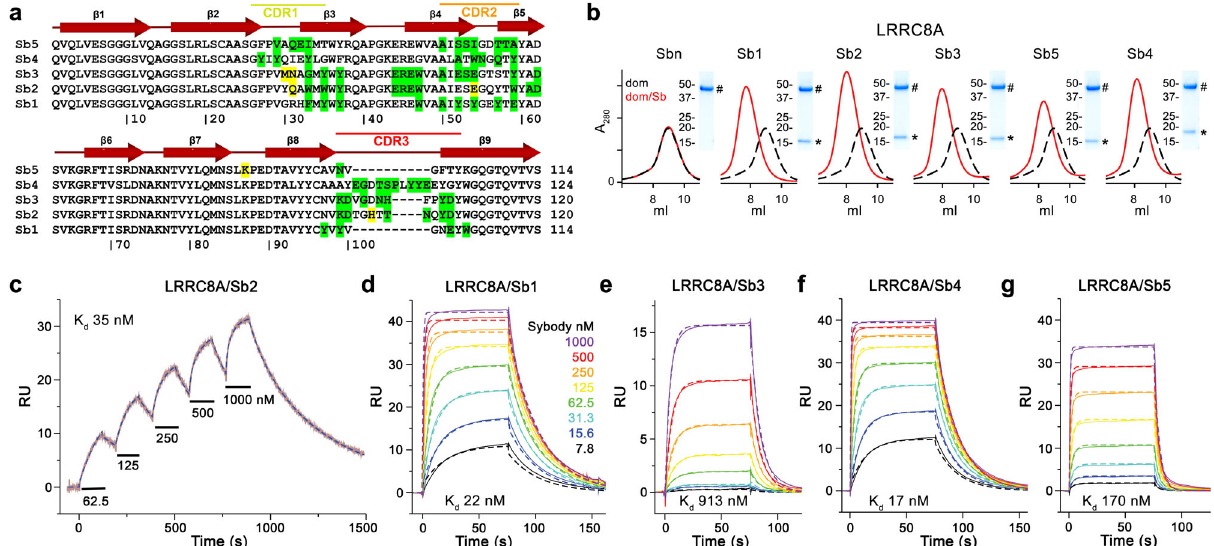
Fig. 1 Biochemical characterization of sybodies targeting the LRR domains. a Sequence alignment of the fi ve modulatory sybodies. Residues involved in the interaction with the primary subunit are highlighted in green, contacts to the secondary subunit in yellow. Secondary structure elements and location of CDRs are indicated above. b Sections of size-exclusion chromatograms showing the elution of the LRR domain of LRRC8A (black dashed line) and its complex with interacting sybodies (red). Sbn refers to the mixture of the LRRC8A domain with a sybody targeting a protein unrelated to the LRRC8 family. Insets show SDS-PAGE gels of the peak fractions with the LRR domain of LRRC8A (#) and co-eluted sybodies (*) indicated. Numbers refer to the molecular weight (kDa). c – g SPR experiments of sybodies binding to immobilized LRR domains of LRRC8A. c Characterization of the binding properties of sybody Sb2. Bars indicate application of the sybody at increasing concentrations (nM). d Af fi nity determination of sybodies Sb1, e Sb3, f Sb4, and g Sb5. d – g Individual traces show association and dissociation of sybodies at concentrations indicated in d and coded in the same color. c – g Dashed lines superimposed on the respective recordings and dissociation constants were obtained from a fi t to a 1:1 binding model. Table 1 Kinetic and dissociation constants of LRRC8A-LRR domain-sybody interactions obtained by SPR.